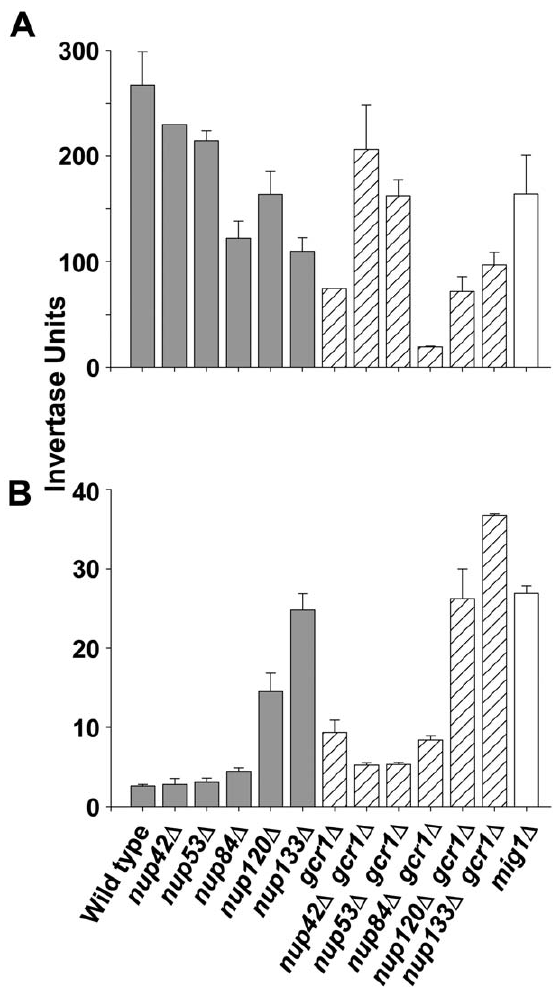
Figure 1. Different nucleoporins make specific contributions to regulation of SUC2 expression. Invertase activity in wild type (WT) and mutant strains grown under either de-repressing (A) or repressing (B) conditions. Error bars represent the standard error of the mean for four independent determinations.